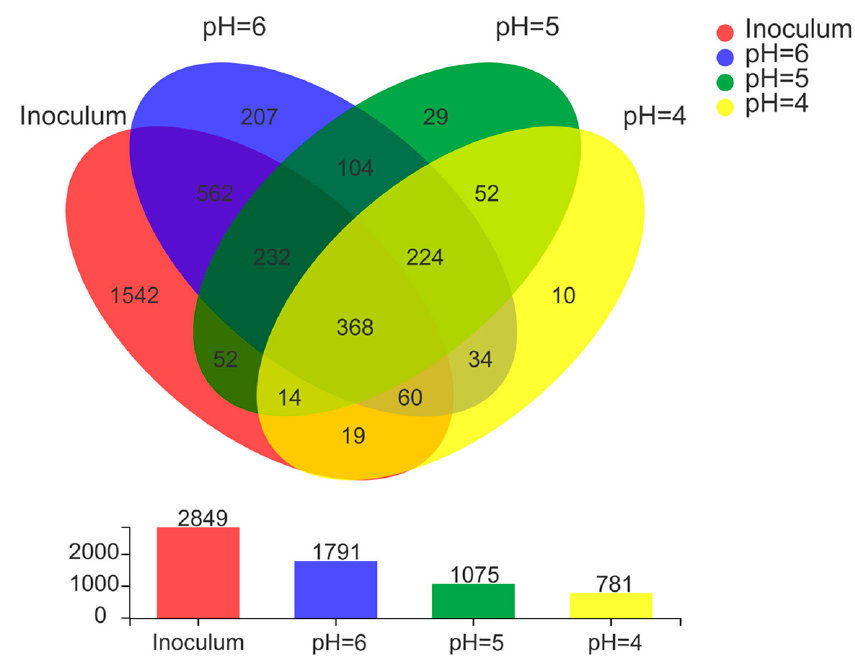
Figure 4. Venn diagram analysis of OTU of electroactive biofilm at different pH.